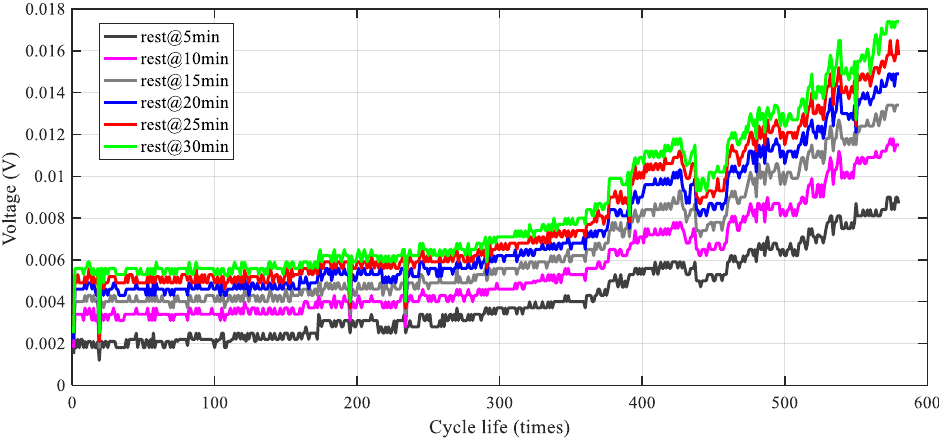
Figure 7. Changes in terminal voltage with different cycle lives.